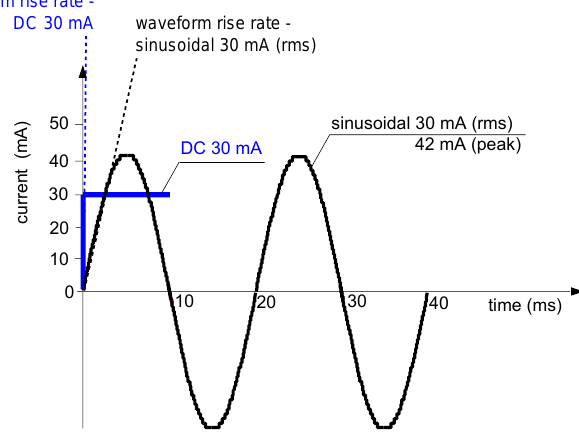
rate d i ∆ /d t (d i p /d t ). Such a property may give an unexpectedly positive reaction to a DC